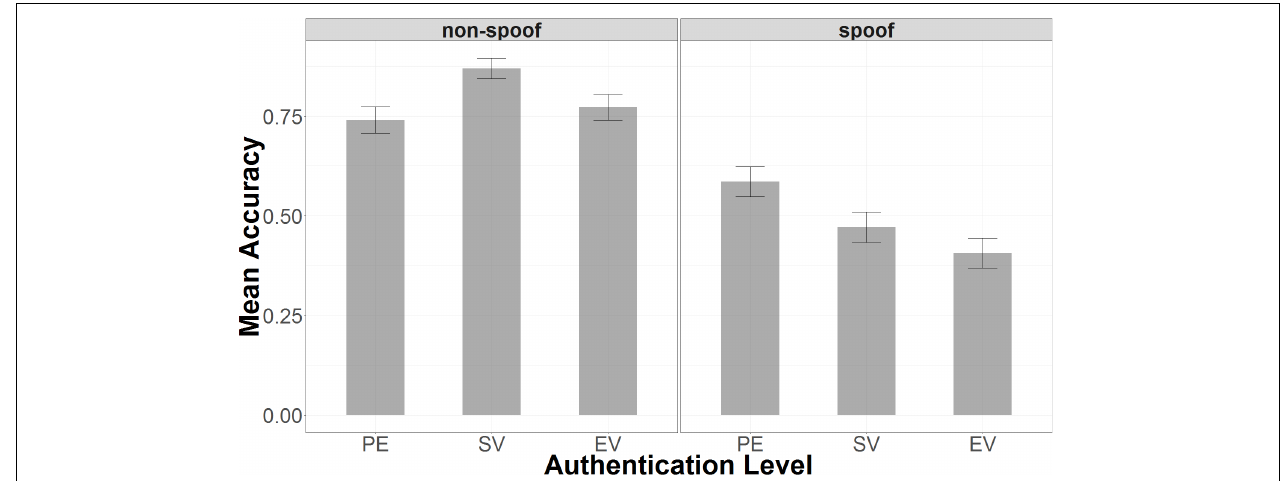
FIGURE 3 | Accuracy plotted as a function of authentication level and non-spoof/spoof condition.